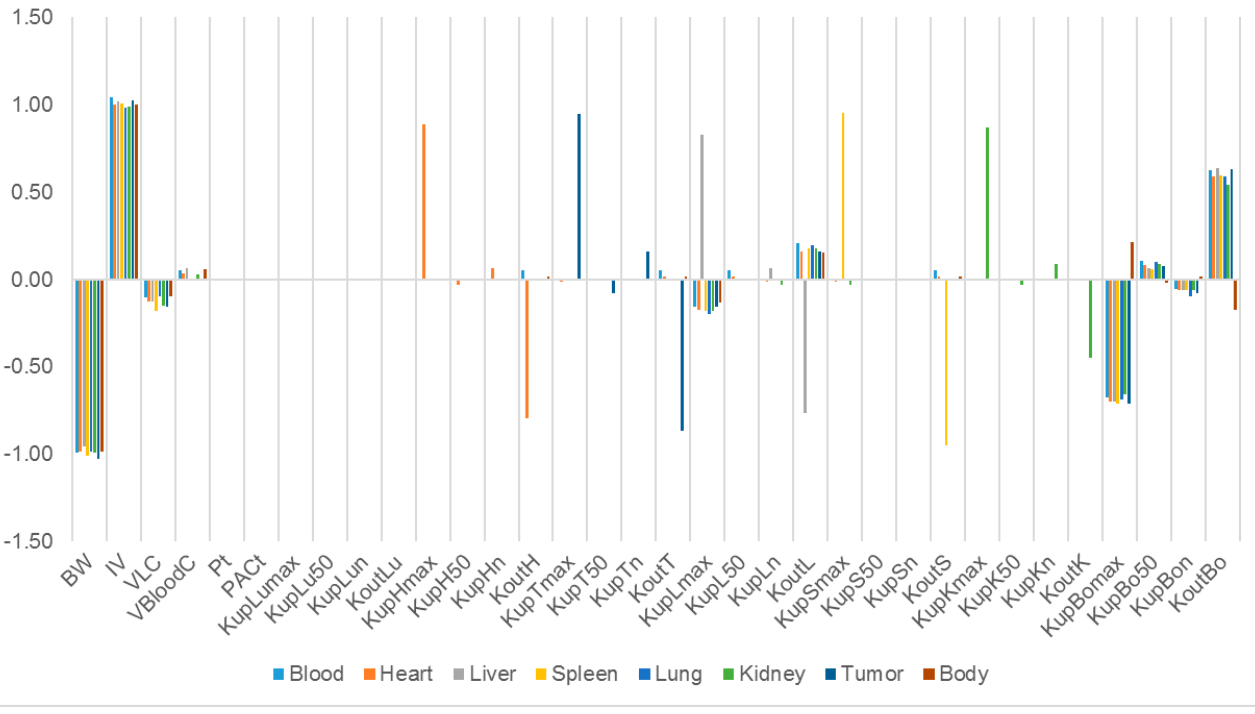
Figure 11. Relative sensitivity analyses for the parameters of mPEG2k-28.57%-200 nm NPs.